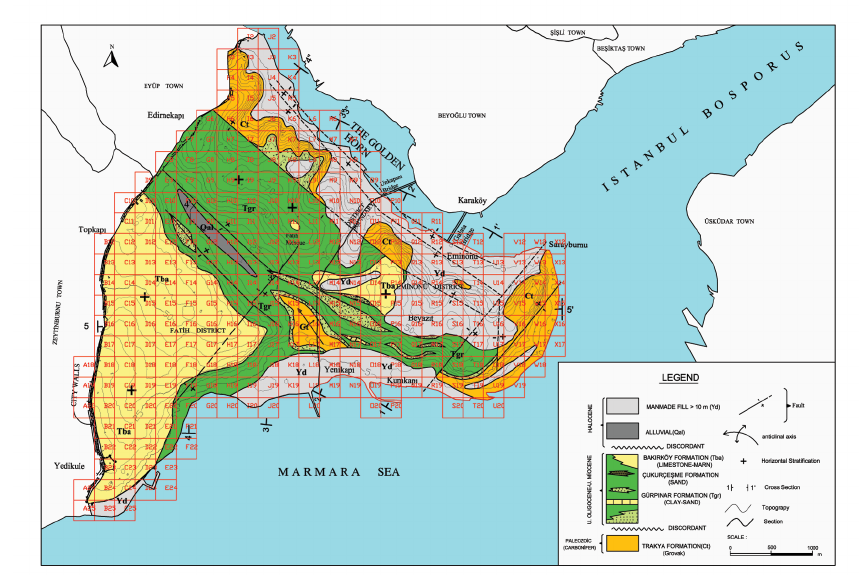
Fig. 6. Engineering Geological Map of the Historical Peninsula ( ¨Ozaydın et al.,